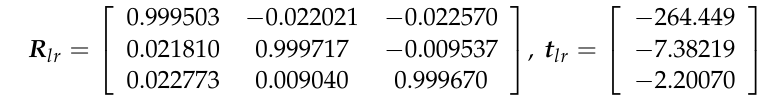
Table 1. Internal parameter coefficients of two cameras.